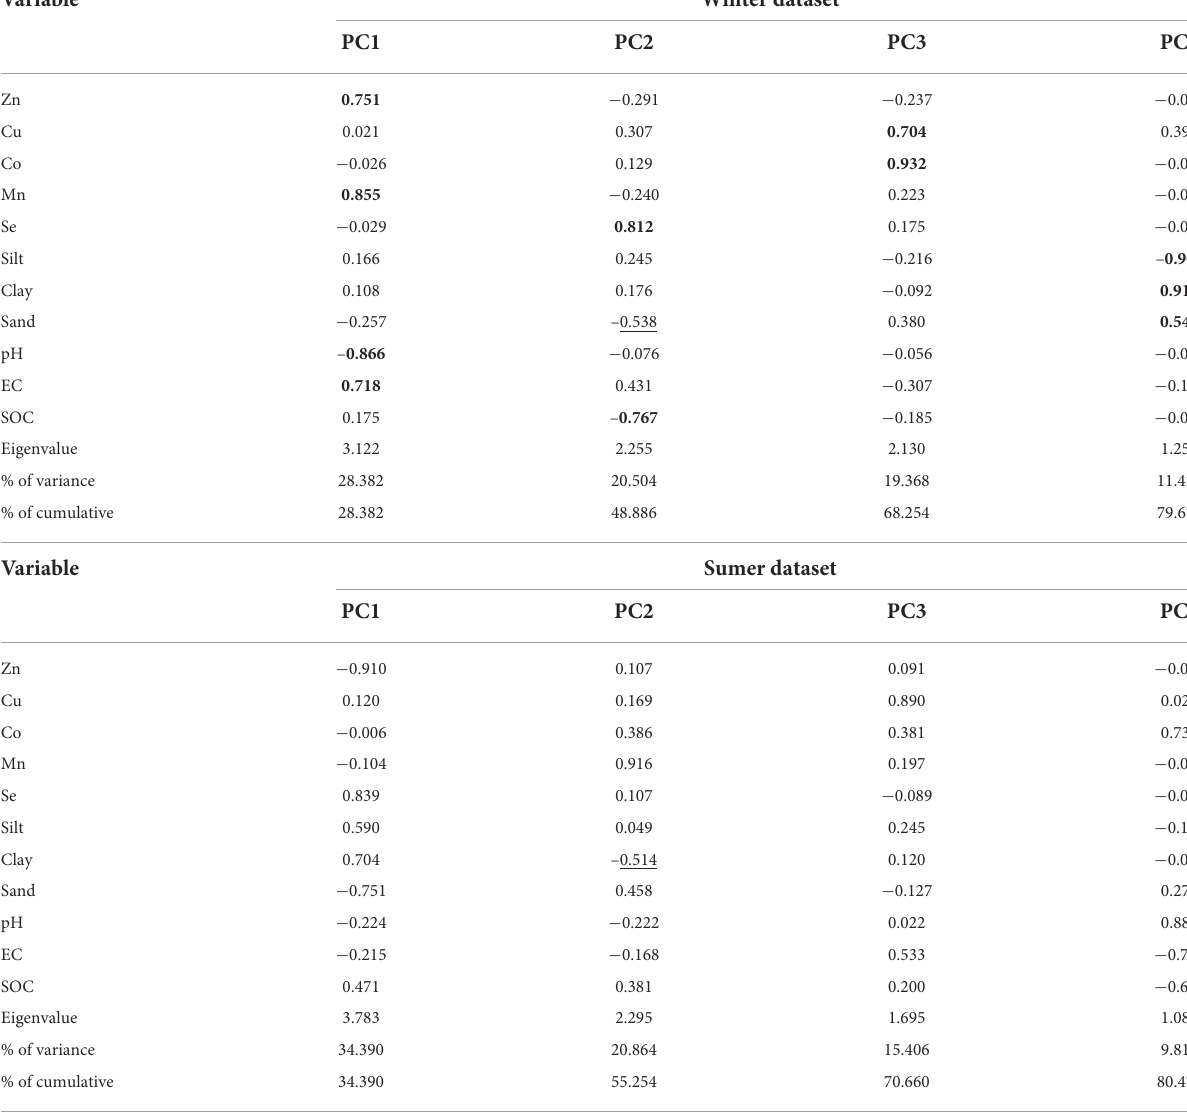
TABLE 2 Rotated component matrix for winter- and summer-collected soil datasets of the hydric soils of Shadegan wetland.